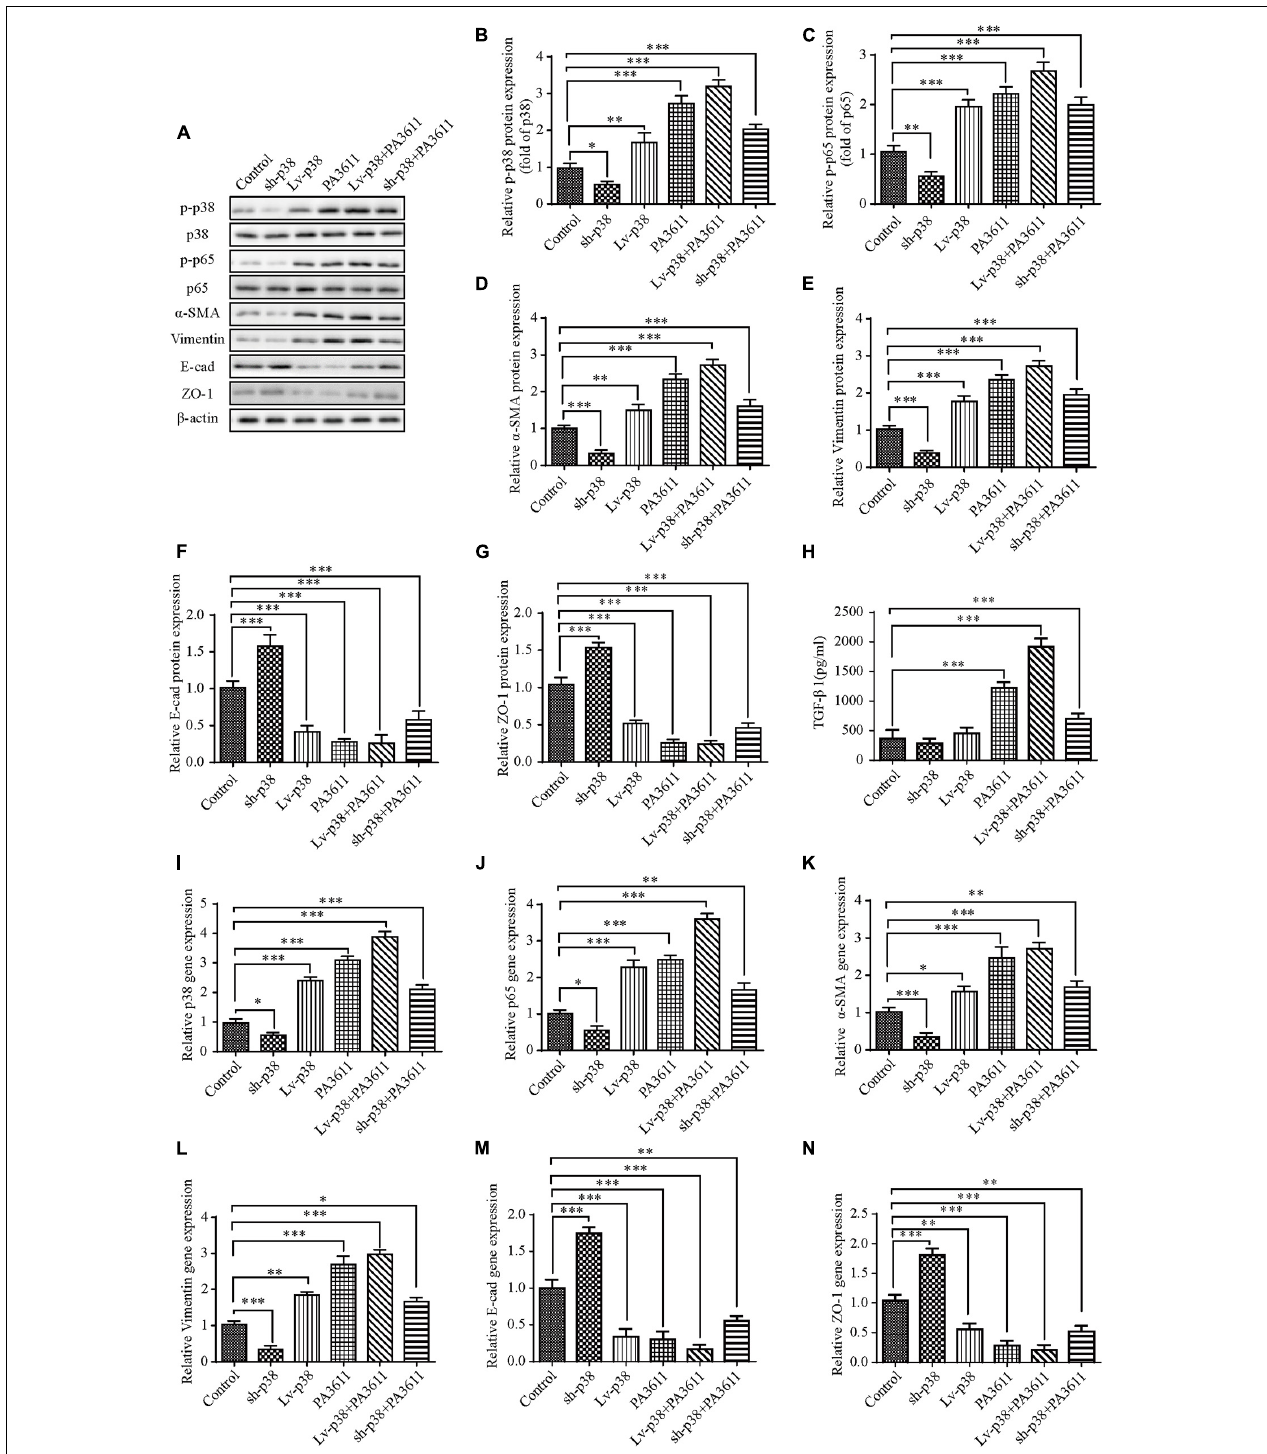
FIGURE 6 | Effects of p38 overexpression or knockdown on the expression of TGF- β 1, EMT-related marker expression and the phosphorylation of p38 and p65. 16HBE14o- cells were transfected with a control vector (indicated as blank), a p38 overexpression vector (indicated as p38), or a specific siRNA directed against p38 (indicated as sh-p38). Twenty-four hours post-transfection, cells were treated with PBS (negative control) or PA3611 (10 µ g/mL) for another 48 h. Then, cell culture supernatants were collected for TGF- β 1 level evaluation by enzyme-linked immunosorbent assay (H) , and cells were collected to examine the gene and protein expression of p38, p65 and EMT-related markers (A–G,I–N) . The results are representative of three independent experiments. The data are presented as the means ± SD. ∗ P < 0.05, ∗∗ P < 0.01, ∗∗∗ P < 0.001, vs. the control group.